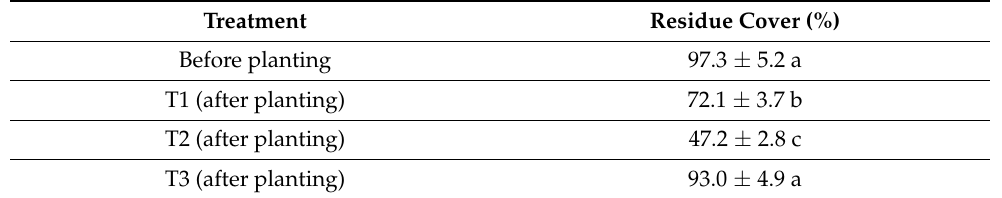
Table 5. Surface residue cover recorded before and after planting left by the assembly used for seeding (3-year averages ± SD). Different letters indicate that mean values are significantly different at a 95% confidence interval. Treatments were Tc + DDO (T1), Rc + Tc + DDO (T2), and no Tc + DDO (T3), where Tc is turbo coulter blade, Rc is row cleaner, and DDO is double-disc opener.